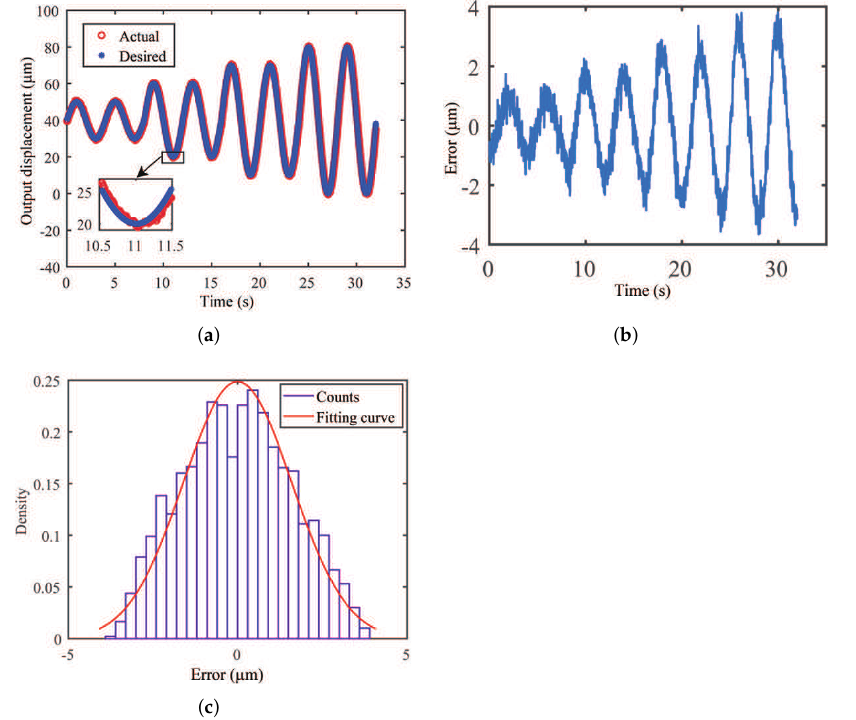
Figure 14. Experimental result of position tracking with PI controller for sine wave of varying dis- placement amplitudes. ( a ) Reference and actual displacements, ( b ) position tracking error, and ( c ) his- togram of position tracking error.